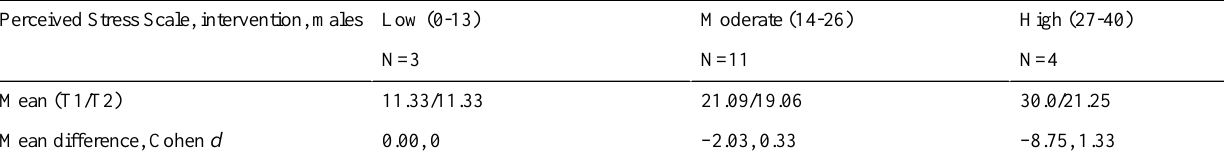
Table 16. Analysis of Perceived Stress Scale categories: